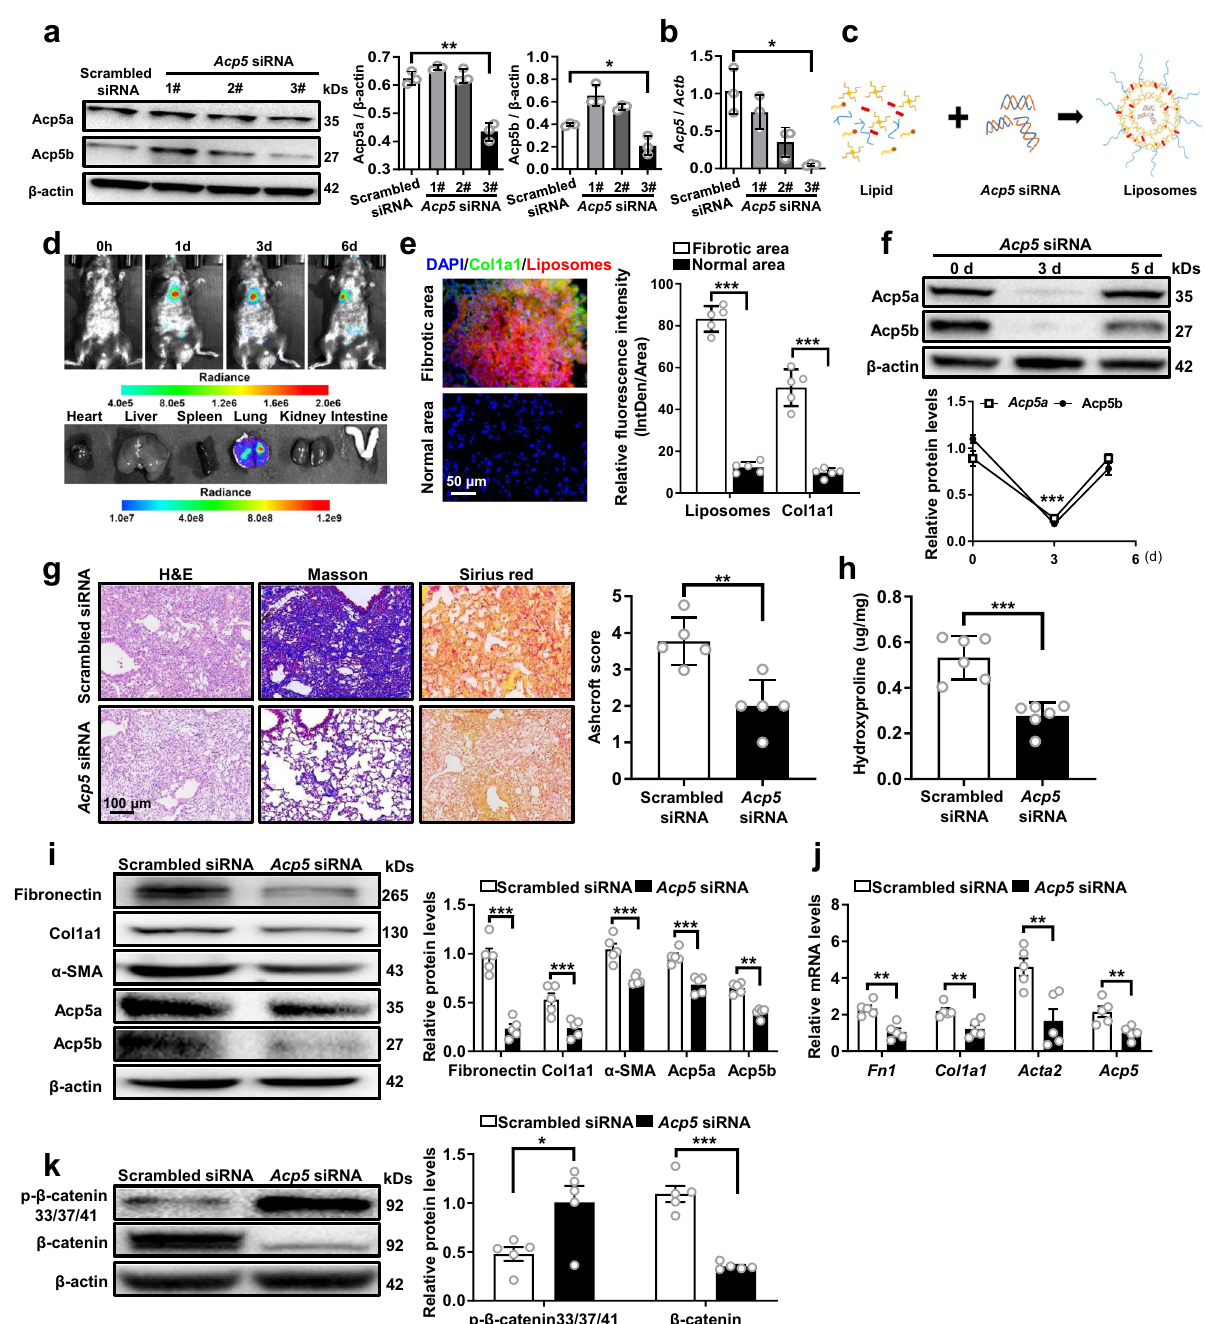
Fig. 7 Administration of Acp5 siRNA-loaded liposomes protected mice from BLM-induced lung injury and fi brosis. a , b Western blot ( a , Acp5a: p = 0.0011, Acp5b: p = 0.0205) and RT-PCR ( b , p = 0.0300) analysis of the interfering ef fi ciency of Acp5 siRNAs in PMLFs ( n = 3 for each group). c Schematic diagram for preparation of liposomes carrying Acp5 siRNA. d The biodistribution of the liposomes in pulmonary fi brosis model mice ( n = 6). e Representative images of immuno fl uorescence for the biodistribution of liposomes (Red, p < 0.0001) and Col1a1 (Green, p = 0.0003) in lungs from BLM- induced mice ( n = 6). The nuclei were stained blue by DAPI, and the images were taken under original magni fi cation ×400. f Temporal Acp5 expression changes in lungs from transfected mice ( n = 5, p < 0.0001). g Histological analysis of the severity of lung fi brosis in mice after BLM induction